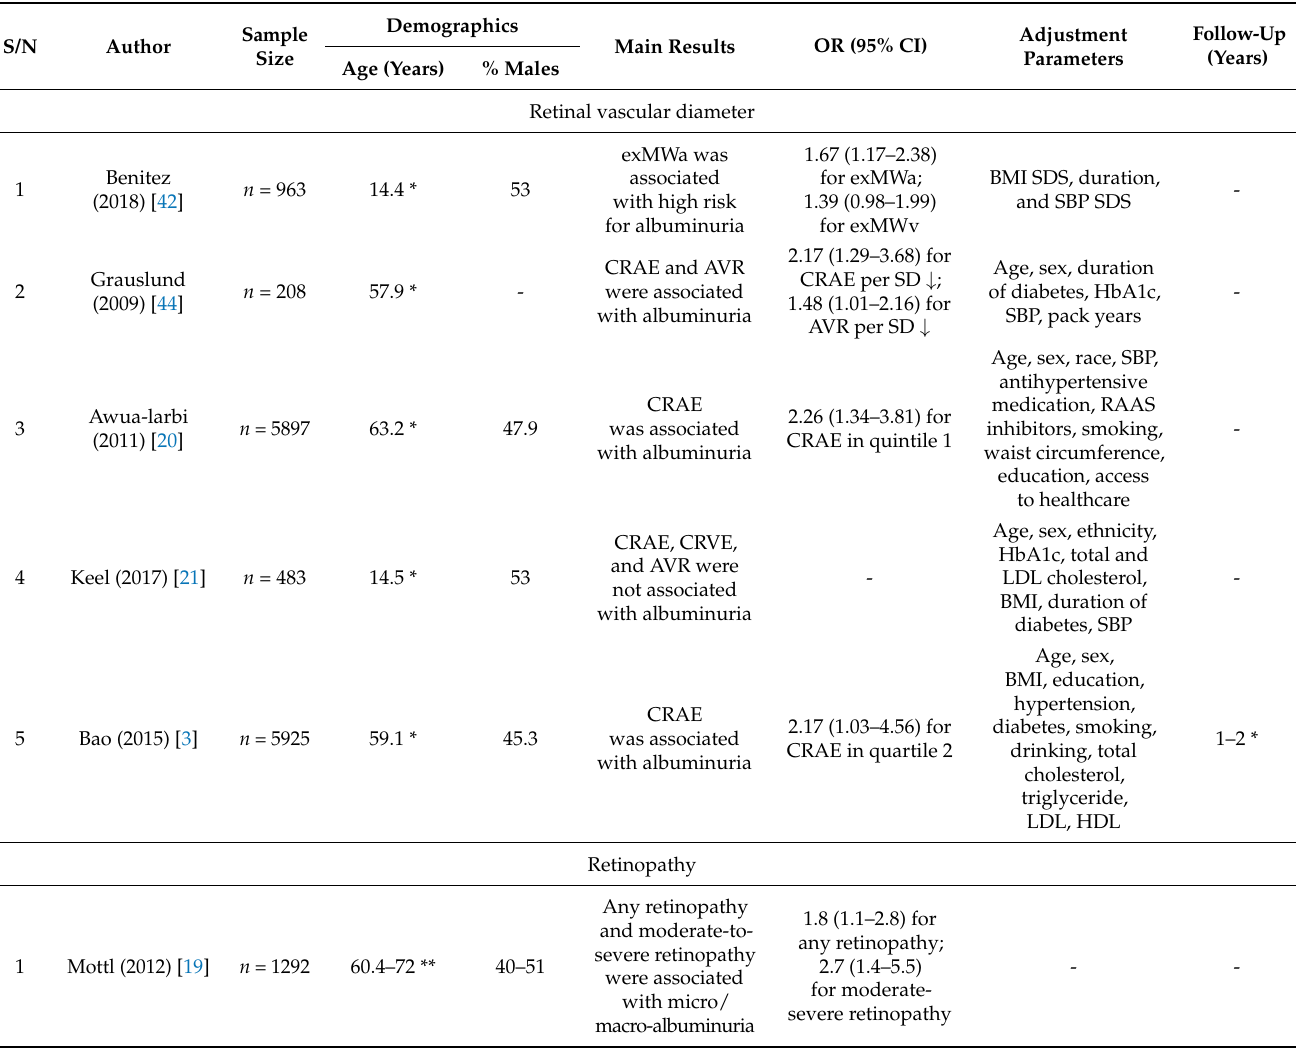
Table 11. Retinal microvascular signs and concurrent albuminuria in diabetic